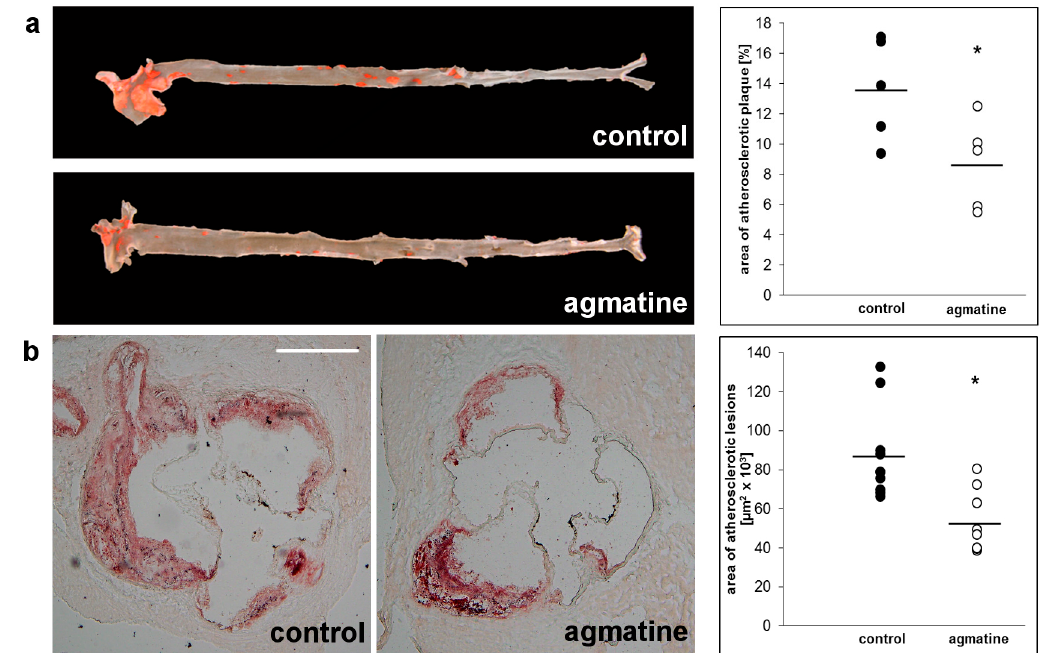
Figure 1. Oil Red O stained representative aortas in control group and agmatine-treated group. Percentage of area occupied by atherosclerotic lesions measured by the en face method in the control group and agmatine-treated group ( a ); representative micrographs showing Oil Red O stained lesions in control group and agmatine-treated group. Atherosclerotic lesions area is measured by the cross-section method in control group and agmatine-treated group ( b ). Black lines indicate mean values (* p < 0.05). Each dot represents a single mouse in control (black dots, n = 10) or agmatine-treated (white dots, n = 8) group. The scale bar represents 500 μ m.